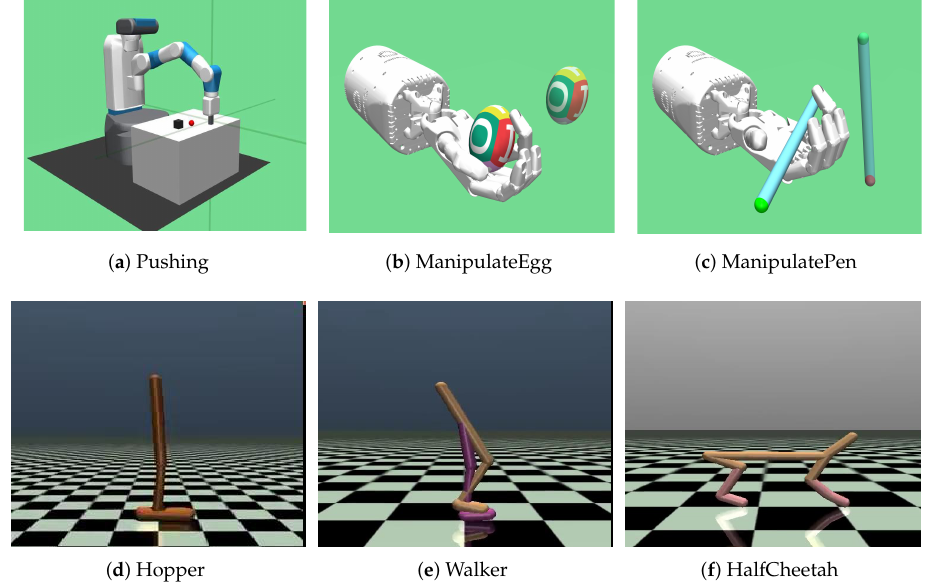
Figure 1. High-dimensional continuous control tasks suffering from sparse rewards. ( a – c ) Object manipulation tasks with a fetch robotic arm or a shadow dexterous hand; ( d – f ) motion control tasks with simulated physics. We consider it a success if an agent achieves the desired goal state within some task-specific